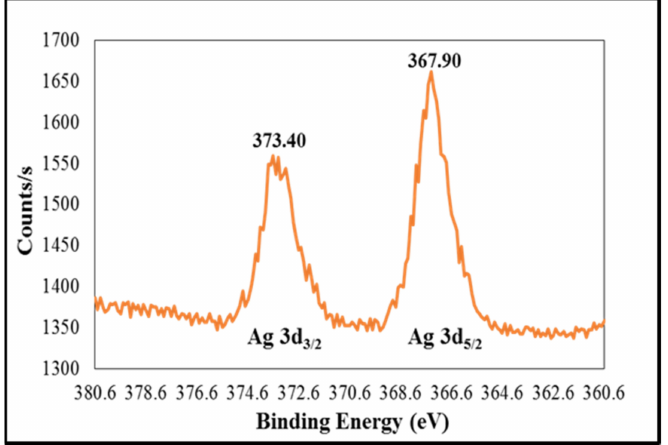
Figure 3. XPS (X-ray Photoelectron Spectroscopy) spectrum of the high-valence Ag(II)PRO